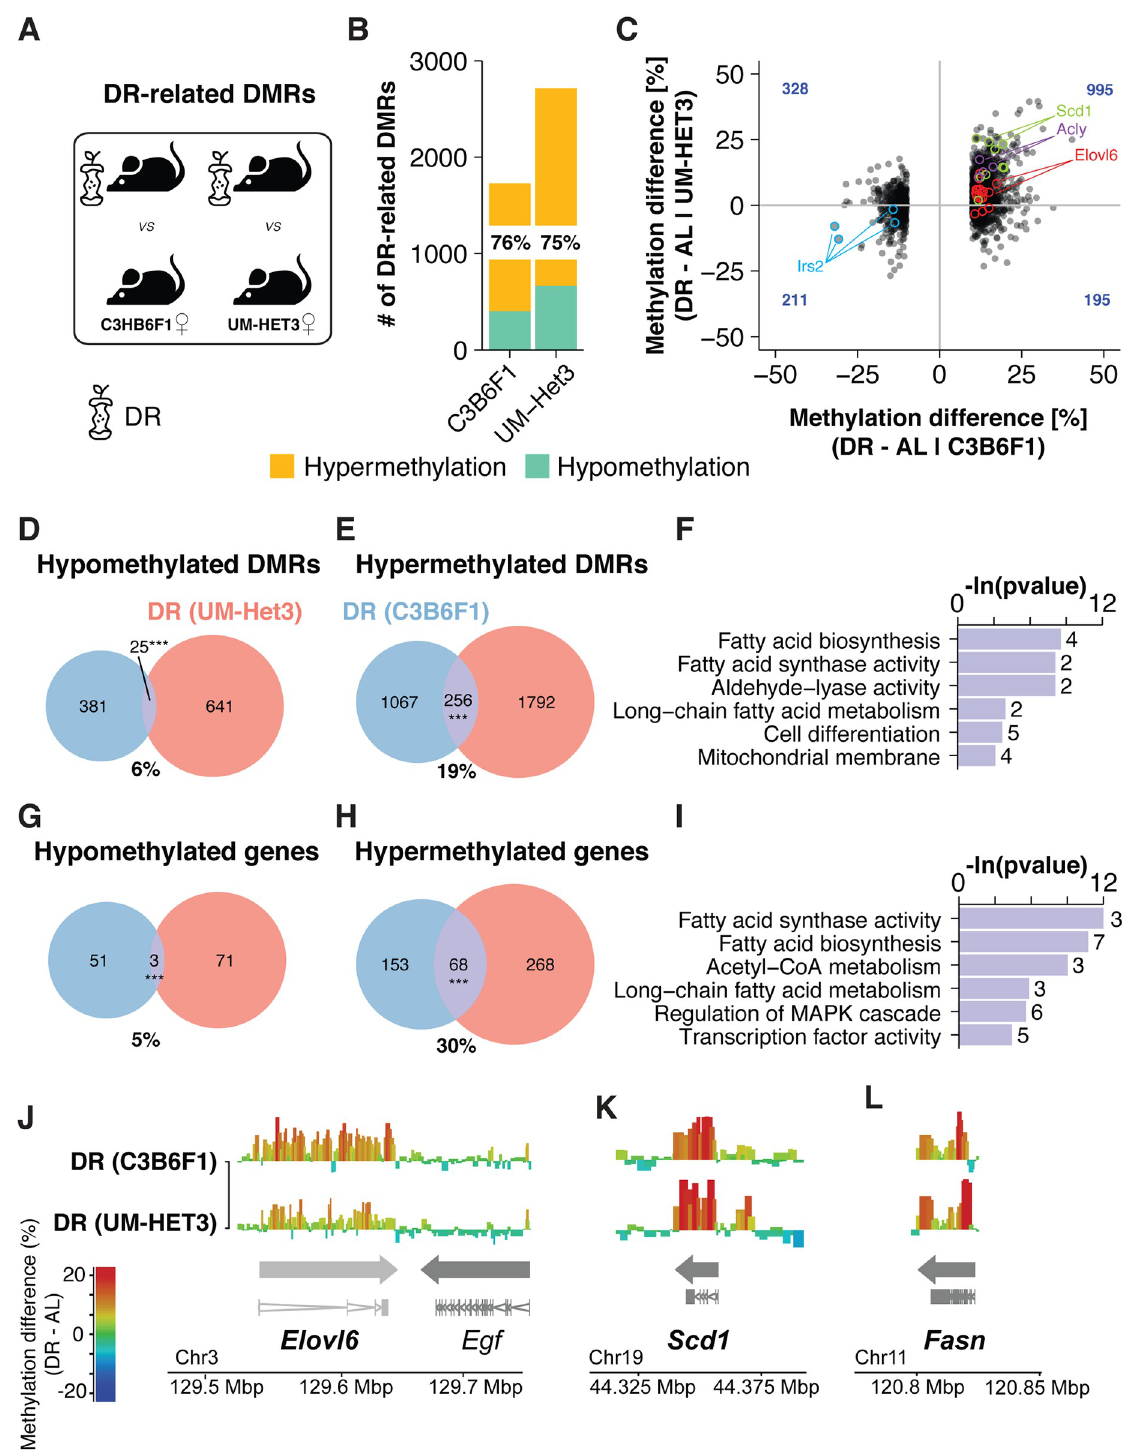
Fig 1. Dietary restriction-related methylation changes are conserved across mouse strains. (A) Schematic representation of the data sets analysed and comparisons made. We probed for Dietary Restricted (DR)-related DMRs at old age in B6C3F1 and UM-HET3 ♀ mice to test their conservation across mouse strains. Pre-processing was conducted in parallel for all experimental groups (B) Number of DMRs (p < 0.05, ± 10% < DNA methylation difference) between each DR cohort and its respective control. Proportion of hypermethylated DMRs are indicated in %. (C) Scatterplot comparison of bin-wise differences between DR-related DMRs in C3B6F1 ♀ mice versus changes in